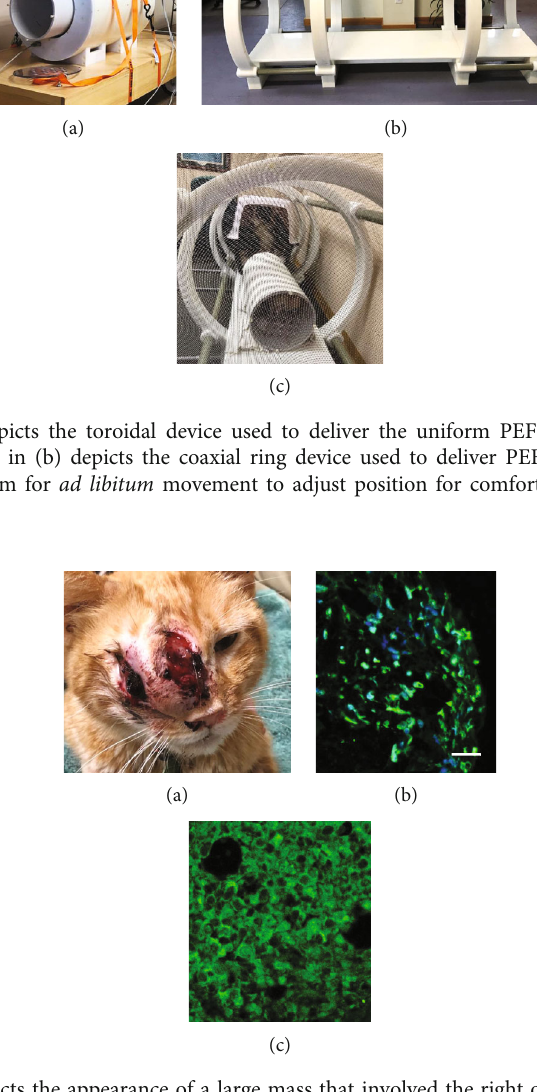
Figure 2: The photograph in (a) depicts the appearance of a large mass that involved the right orbit and at the time of presentation had erupted through the skin as an open wound over the bridge of the nose and face. The photomicrograph in (b) depicts the prominent immunohisto fl uorescent labeling of VGSCs (green) observed in a tissue sample taken from the tumor in (a) before treatment with TOL. For comparison, the photomicrograph in (c) depicts a similarly processed tissue sample showing VGSC expression in a murine homograft that was assessed in a pre-clinical study to determine the e ffi cacy of TOL in treating triple-negative breast cancer. The calibration bar for photomicrographs in B = 25 μ m and nuclei (blue) are labeled with